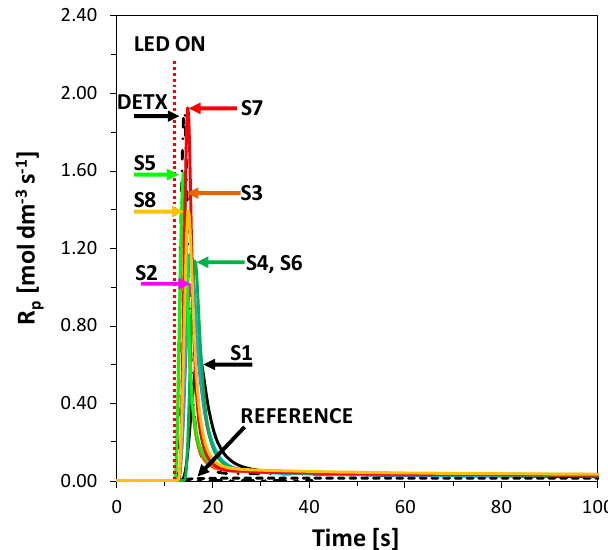
Figure 16. Profiles of TMPTA double bond conversion with HIP (1 wt.%) and 2-amino-4,6-diphenyl-pyridine-3-carbonitrile derivatives (0.1 wt.%) under MPM lamp with 400–500 nm filter (intensity at the surface of sample 75 mW / cm 2 ) irradiation, calculated from photo-DSC data. The irradiation starts at t = 10 s.